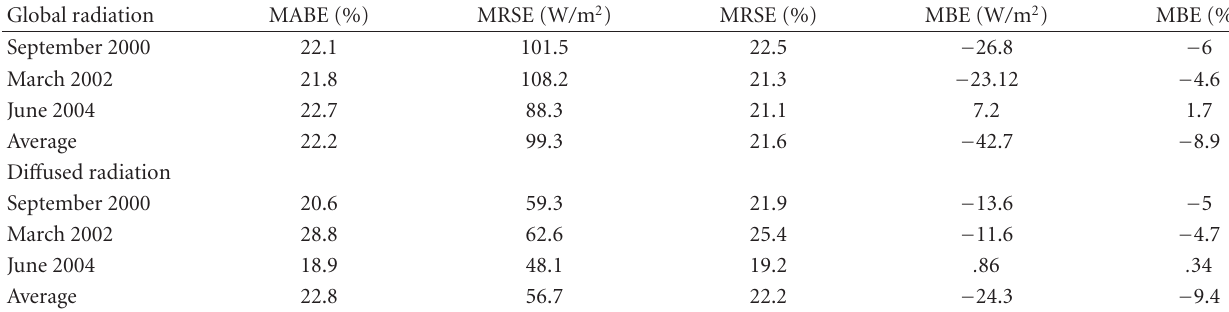
Table 3: Evaluation statistics for CFNN.